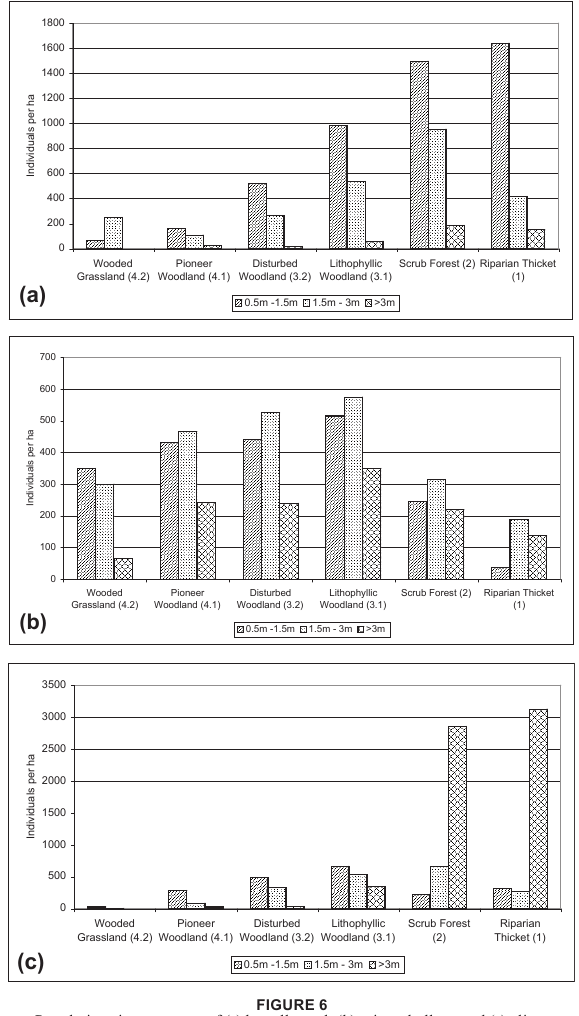
Figure 6 Population size structure of (a) broadleaved, (b) microphyllous and (c) alien- invasive tree species for three height classes in each woody